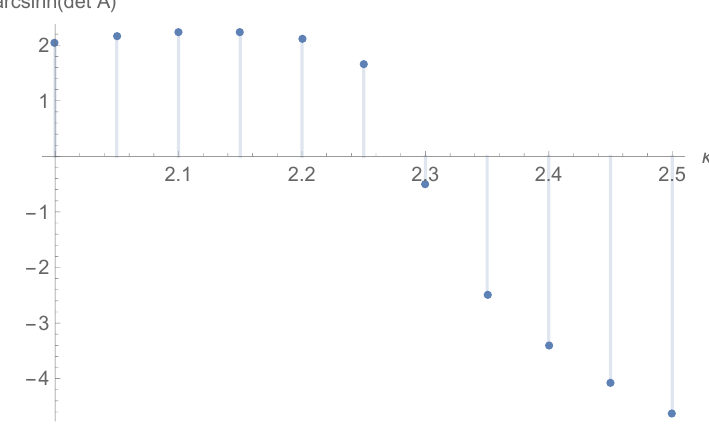
Figure 3 . det A ( (cid:20) ) plot for the 4H (cid:13) solution near the last crossing.